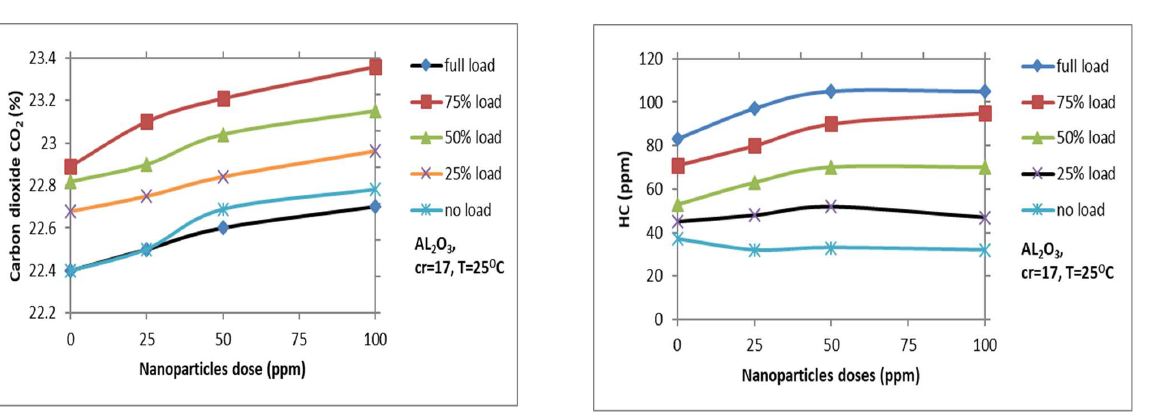
Fig. 10. Unburnt Hydrocarbon Emissions (UHC) with Alumina nanoparticles